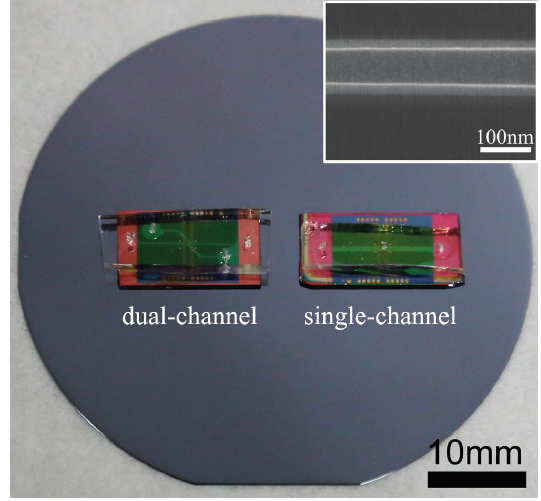
Figure 2. Optical images of fabricated SiNW-FET biosensors with dual-channel and single-channel setups. The inset shows the SEM image of a typical Si